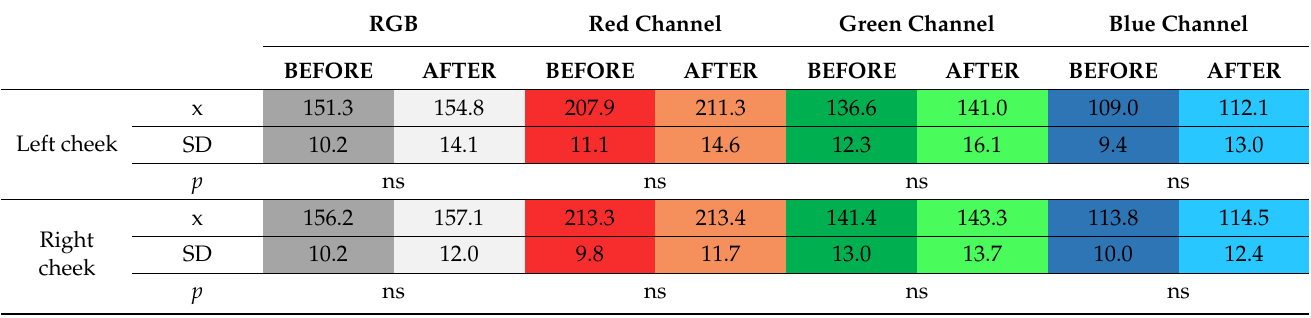
Table 1. Average brightness (a.u.) of the RGB images of the left and right cheeks and the red, green and blue channels after conversion to gray levels before treatments (BEFORE) and after series of treatments (AFTER); x = mean; SD = standard deviation; p = level of statistical significance; ns = not significant. RGB Red Channel Green Channel Blue Channel BEFORE AFTER BEFORE AFTER BEFORE AFTER BEFORE AFTER